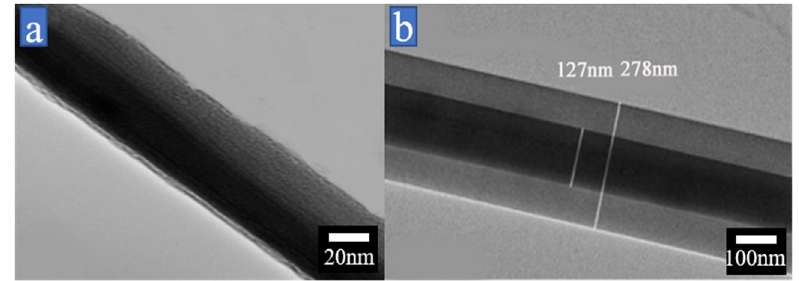
Figure 7: TEM images of ( a ) side - by - side PVAc/PVP fi bers and ( b ) core/shell PLA/CS nano fi bers. ( a ) Adapted with permission ( 121 )